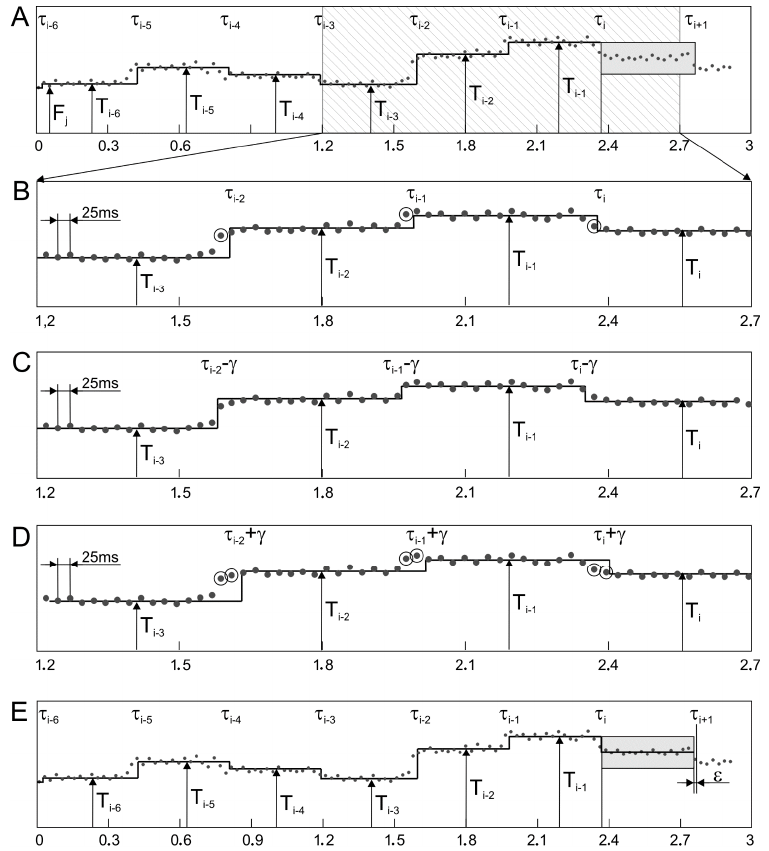
Figure 9. Operation of matching algorithm in the segmentation method based on values of instantaneous periodicity measurements F j ( A ). Three middle graphs ( B, C, D ) show the principle of determining the correction parameter. For seven most recently determined intervals, matching to instantaneous measurement values is tested. If the average di ff erence between F j values and the corresponding values of the intervals T i decreases when the intervals are shifted by γ or − γ (repetition step for